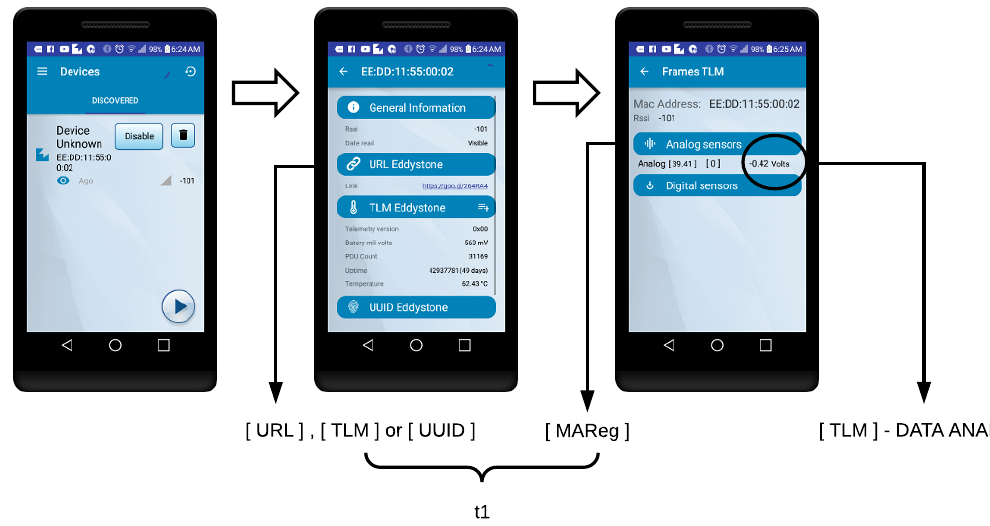
Figure 29. Sequence of screens of the Android application when using the beacon-based